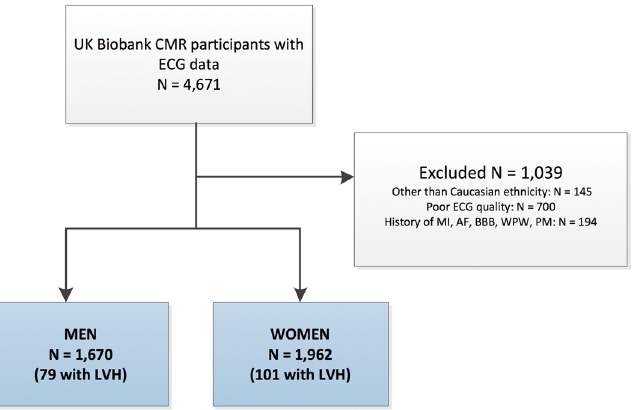
Figure 1. Flowchart of the study population. Al individuals of the UK Biobank CMR substudy with available 12-lead ECG data were included in this study. Individuals with another ethnicity than Caucasian, poor ECG quality or with a history of cardiac disease were excluded from analyses. After exclusion, data of 1670 men and 1962 women was available for analyses. AF Atrial fibrillation, BBB bundle branch block, CMR cardiac magnetic resonance imaging, ECG electrocardiogram, LVH left ventricular hypertrophy, PM pacemaker, WPW Wolff-